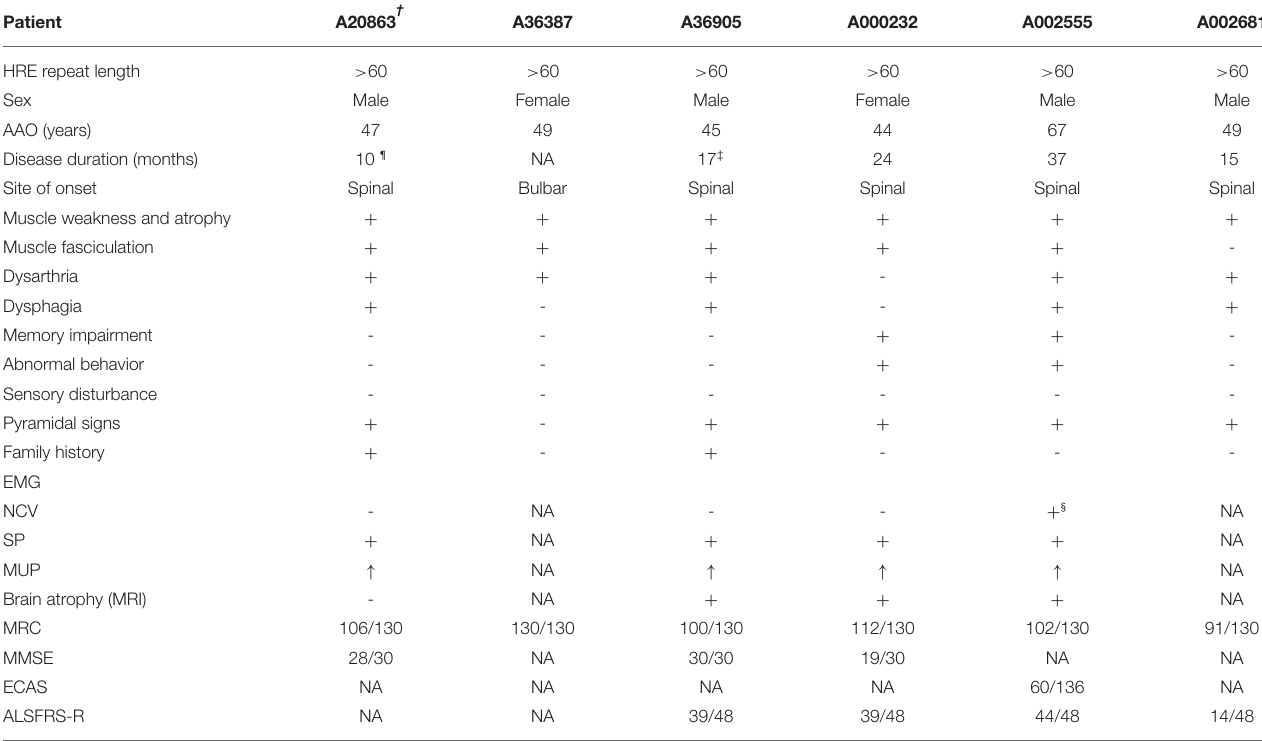
TABLE 2 | Clinical details of patients carrying C9orf72 HREs.